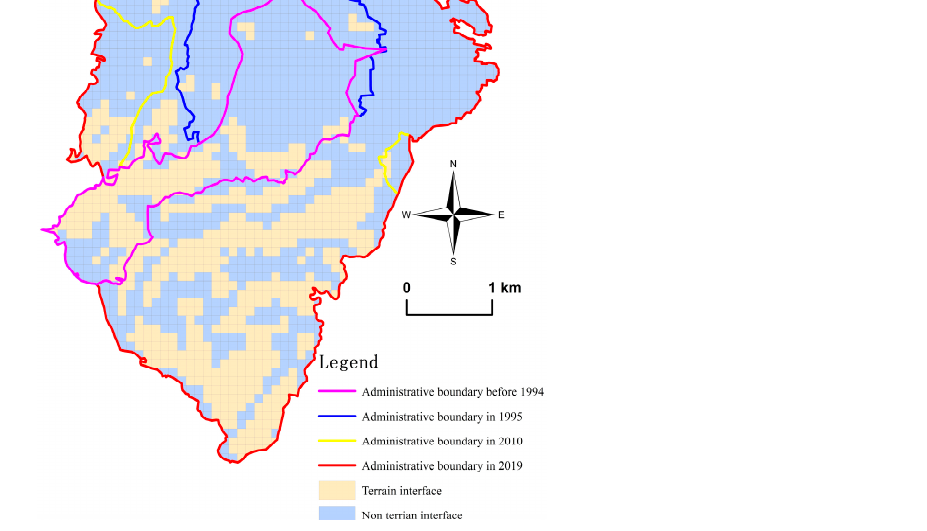
Land 2022 , 11 , 2289 Figure 5. Spatial distribution of Zhulin’s terrain interface. Reference system GCS Xian 1980.